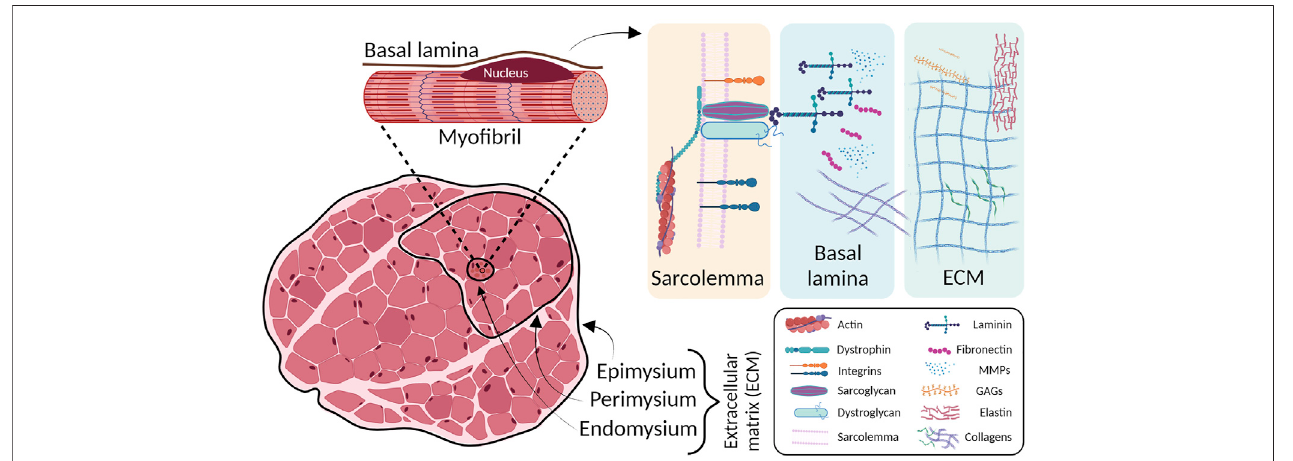
FIGURE1| SkeletalmuscleECMlayersstructure(left)andschematicmagni fi cationonECMprincipalcomponents(right).Theouterlayersofconnectivetissuesare divided into epimysium, perimysium and endomysium. Underneath the basal lamina, in close contact with sarcolemma, the ECM major players are located. MMPs: metalloproteinases; GAGs: